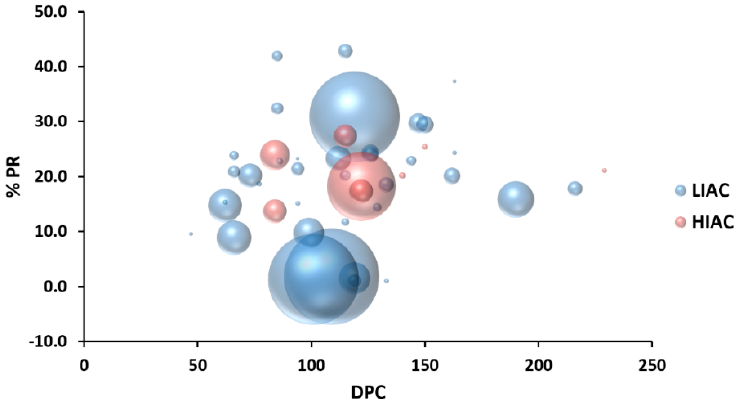
Figure 2. Effect of inherent aerobic capacity on tumor hormone receptor status. For all palpable mammary carcinomas, percent of cells staining positive for progesterone receptor (% PR) was determined. This data, plus the mass of the tumor determined gravimetrically at necropsy and the days post carcinogen (DPC) that the mass was initially detected by palpation were used to construct a bubble chart with the size of each bubble reflecting relative tumor mass.